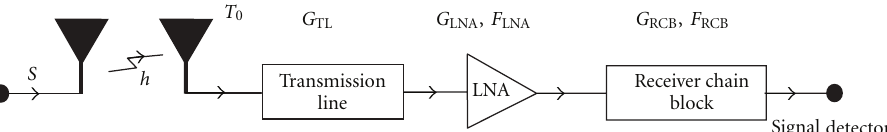
Figure 1: Single RF chain Transceiver.